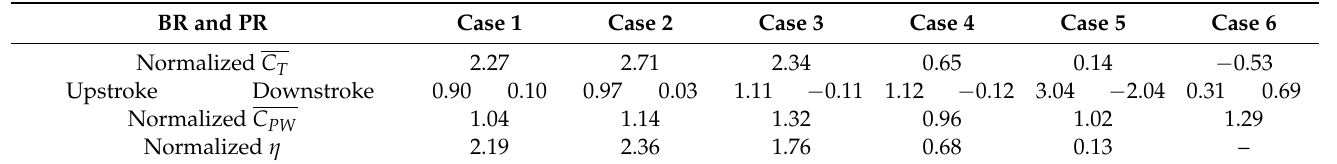
Table 2. Normalized cycle averaged